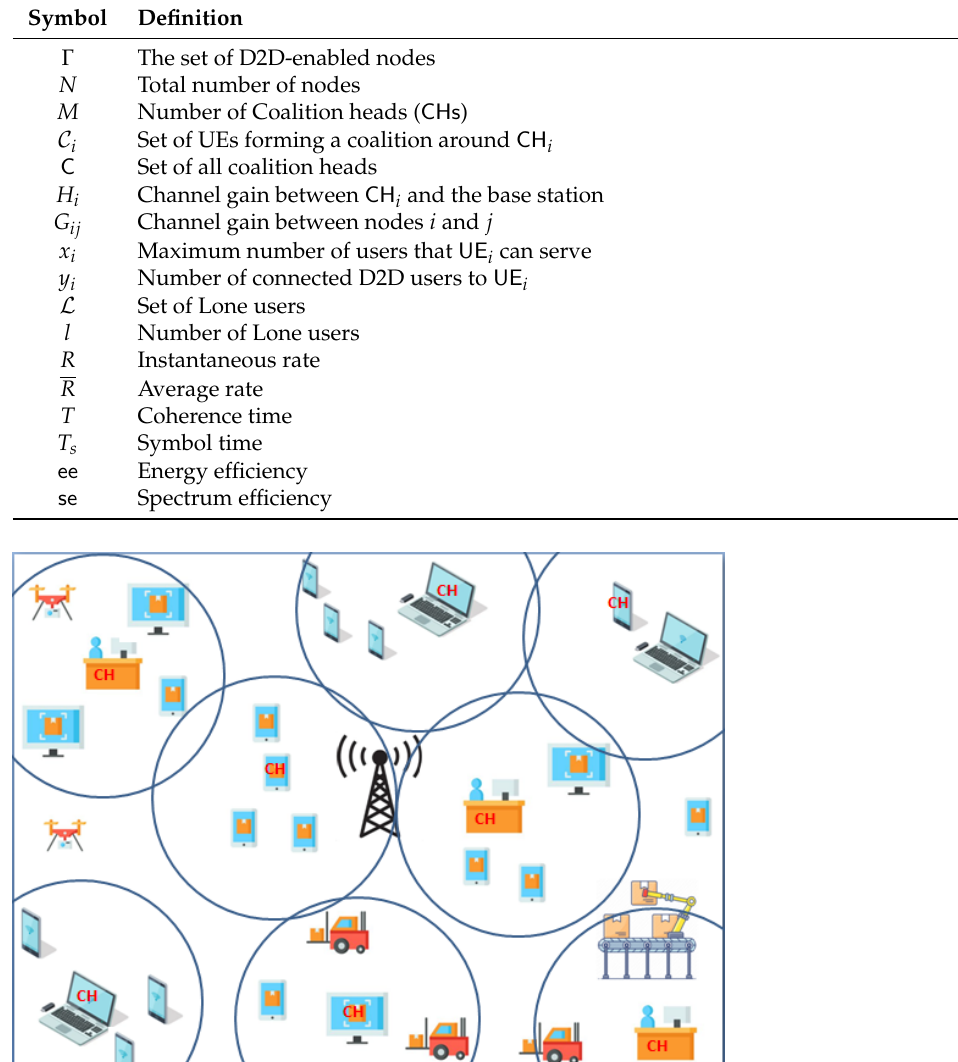
Table 1. List of Notations.